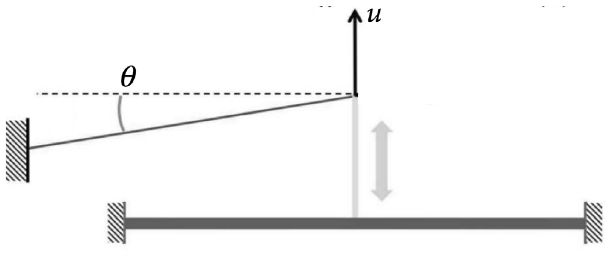
Figure 3. Figure and caption reproduced from Chabassier et al. [12]. Schematic view of strings-soundboard coupling at the bridge. The bridge is supposed to have a displacement u only along the vertical direction. The string forms a small angle h with the horizontal